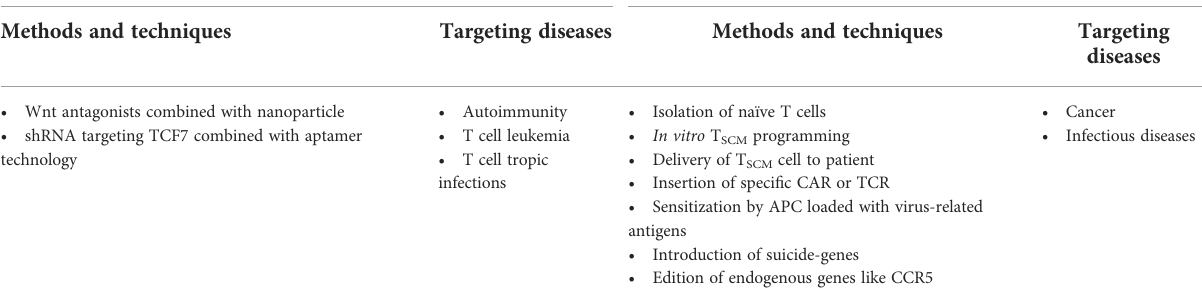
TABLE 2 Overview of researches relating to T SCM -cell-based applications for human diseases (21, 21, 26, 75, 232 – 237). Disruption